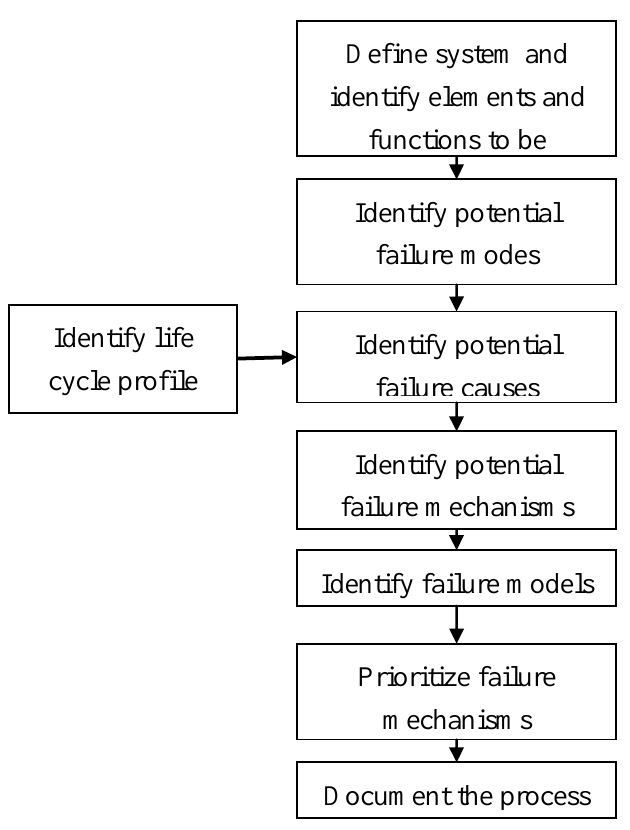
Figure 3. Flowchart of FMMEA process